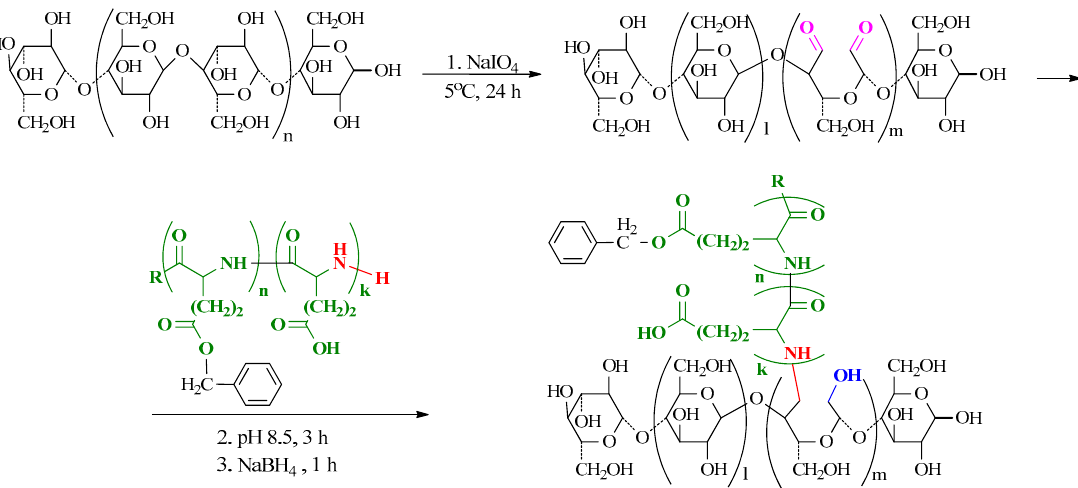
Figure 2. General scheme for the preparation of composite